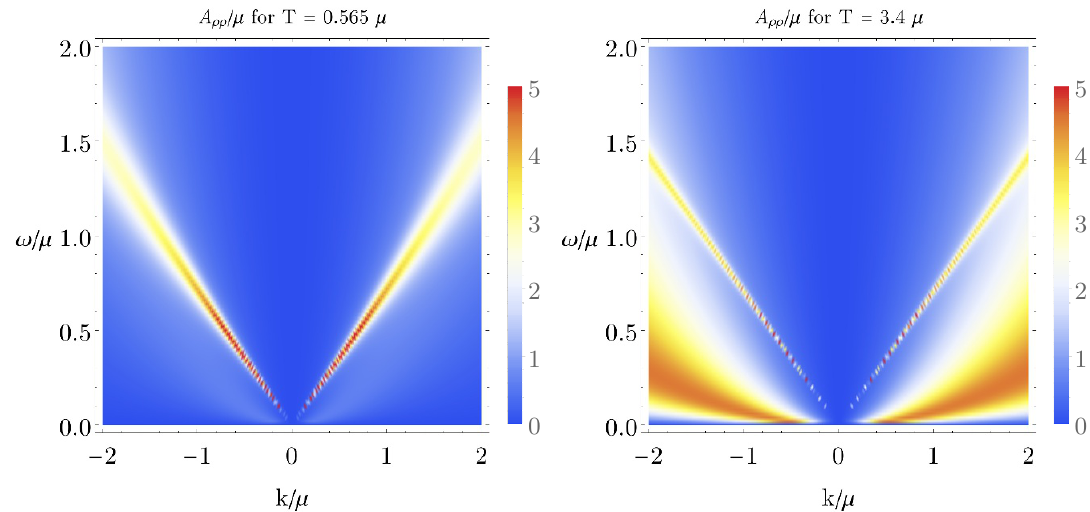
Figure 1. The density spectral function for two di(cid:11)erent values of the temperature in 2 + 1 dimensions. Notice that in addition to the linear sound modes with a low-energy behavior of the p dispersion given by ! = (cid:6)j k j = 2, we can clearly observe the di(cid:11)usive mode, that becomes more dominant as we increase T=(cid:22) .